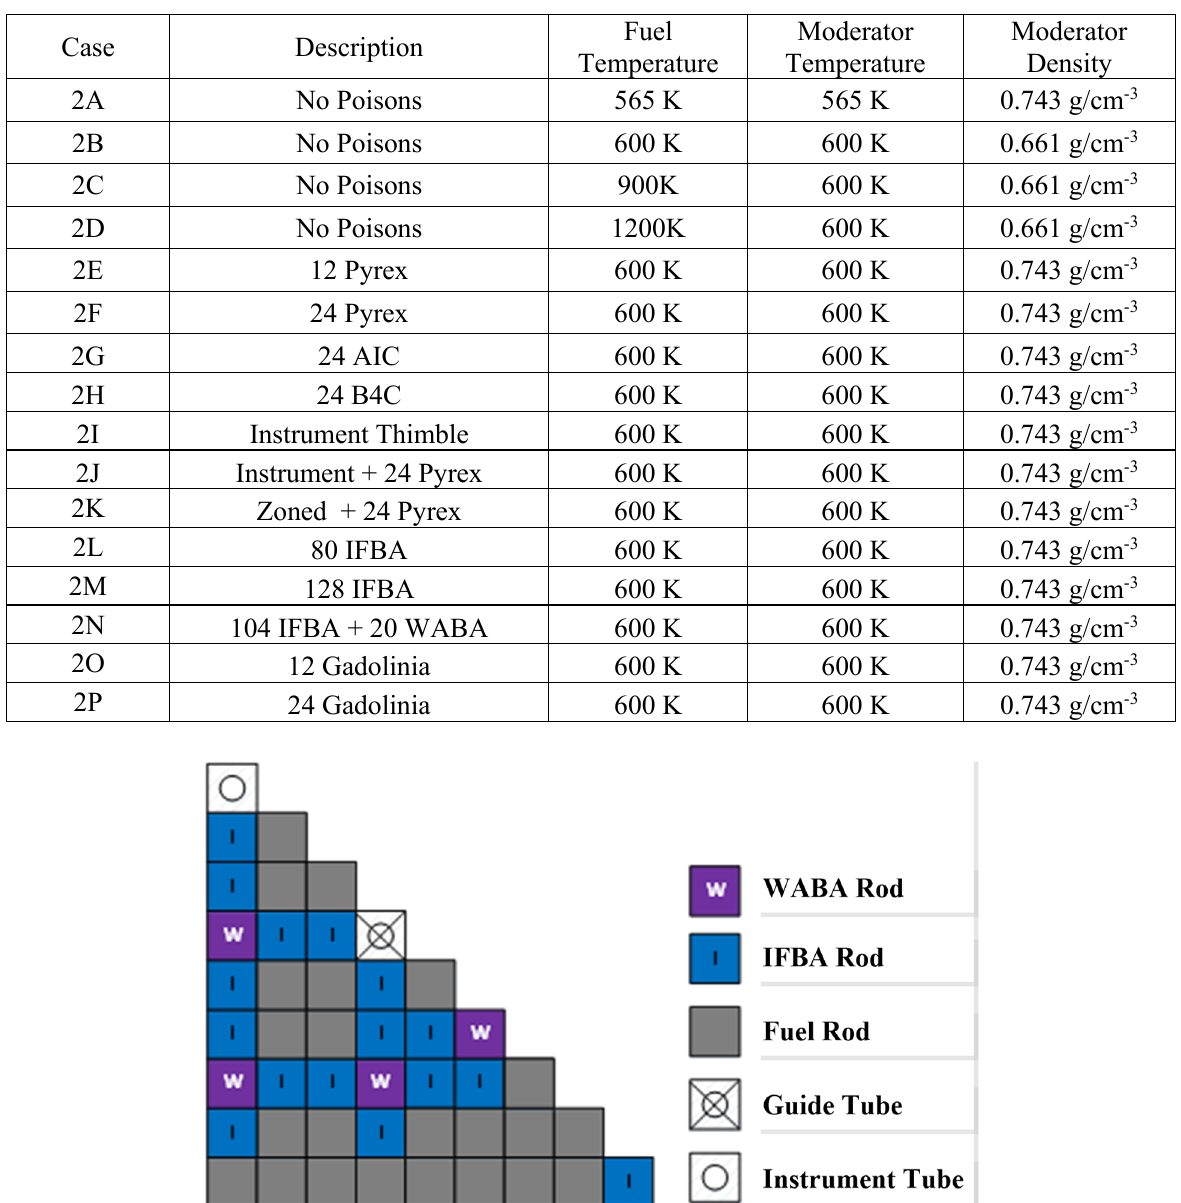
Table I. Problem 2A-2P calculation cases.